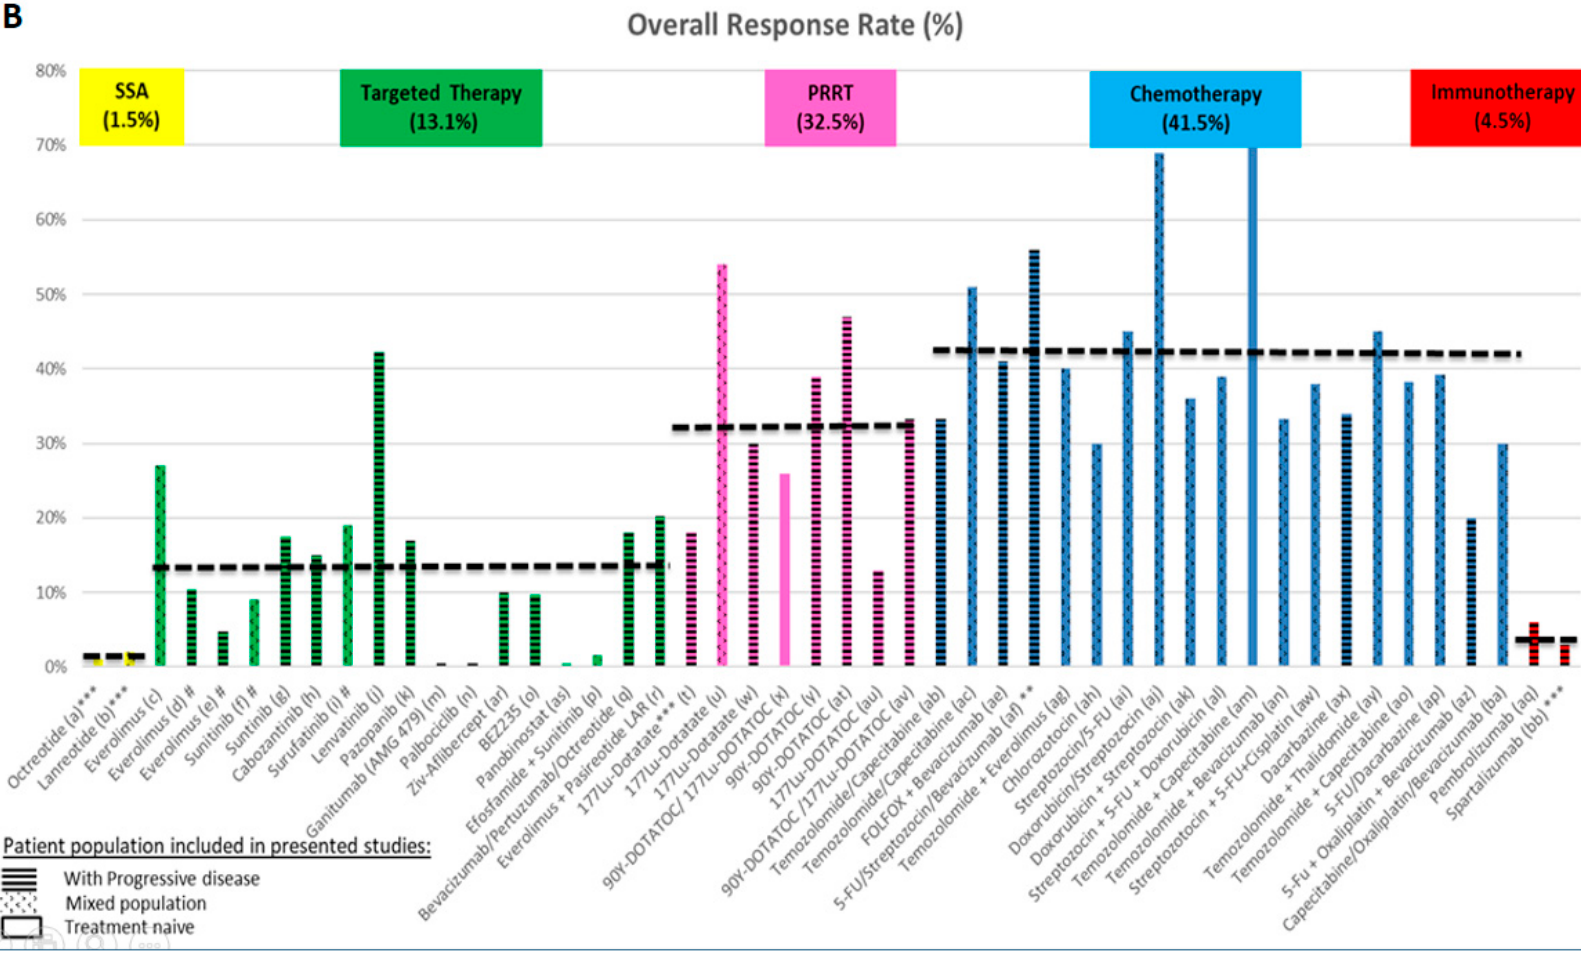
Figure 1. Graphical representation and pooled progression-free survival (PFS) and objective response rate (ORR) by treatment group. Data for the studies summarised in Tables 1–5 are presented. Mean PFS and ORR are calculated from studies with data available. PRRT: Peptide receptor radionuclide therapy; SSA: somatostatin analogue.